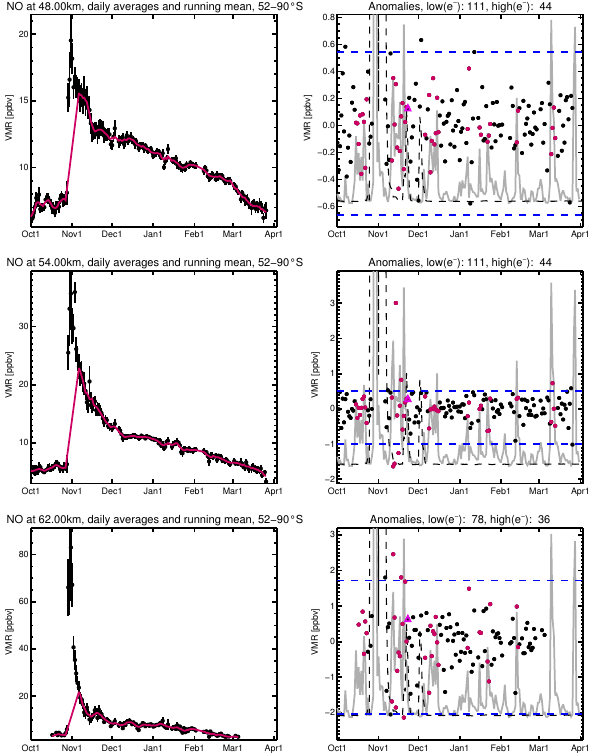
Figure 10. Daytime NO in the latitude region 52–90 ◦ S at three altitudes: 48km (upper panel), 54km (middle panel), and 62km (lower panel). Left panels: daily averages (black dots) and 7-day running mean (red line) excluding the period of largest proton forcing from 27 October to 6 November 2003. Right panels: anomalies (dots, daily average – running mean). Days with enhanced electron fluxes ( ≥ 2 × 10 4 electronscm − 2 s − 1 sr − 1 ) of the 100–300keV channel on this or the previous day are marked in red. Light grey lines show the 100–300keV electron fluxes, dashed black lines the ≥ 10MeV proton flux for reference, both in arbitrary normalized units. Dashed blue lines mark the 1 and 99% percentile of the anomalies, exclud- ing days with enhanced electron fluxes. The violet triangle marks a day with enhanced electron fluxes and ≥ 10MeV proton fluxes.